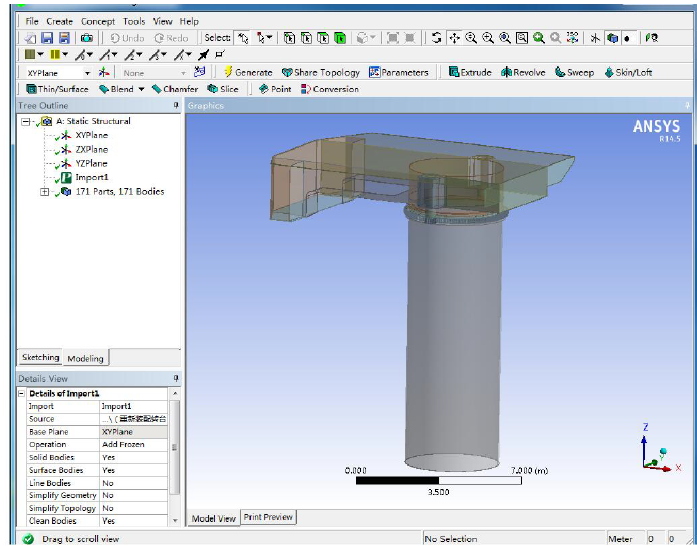
Figure 7. Import of 3D models of assemblies.